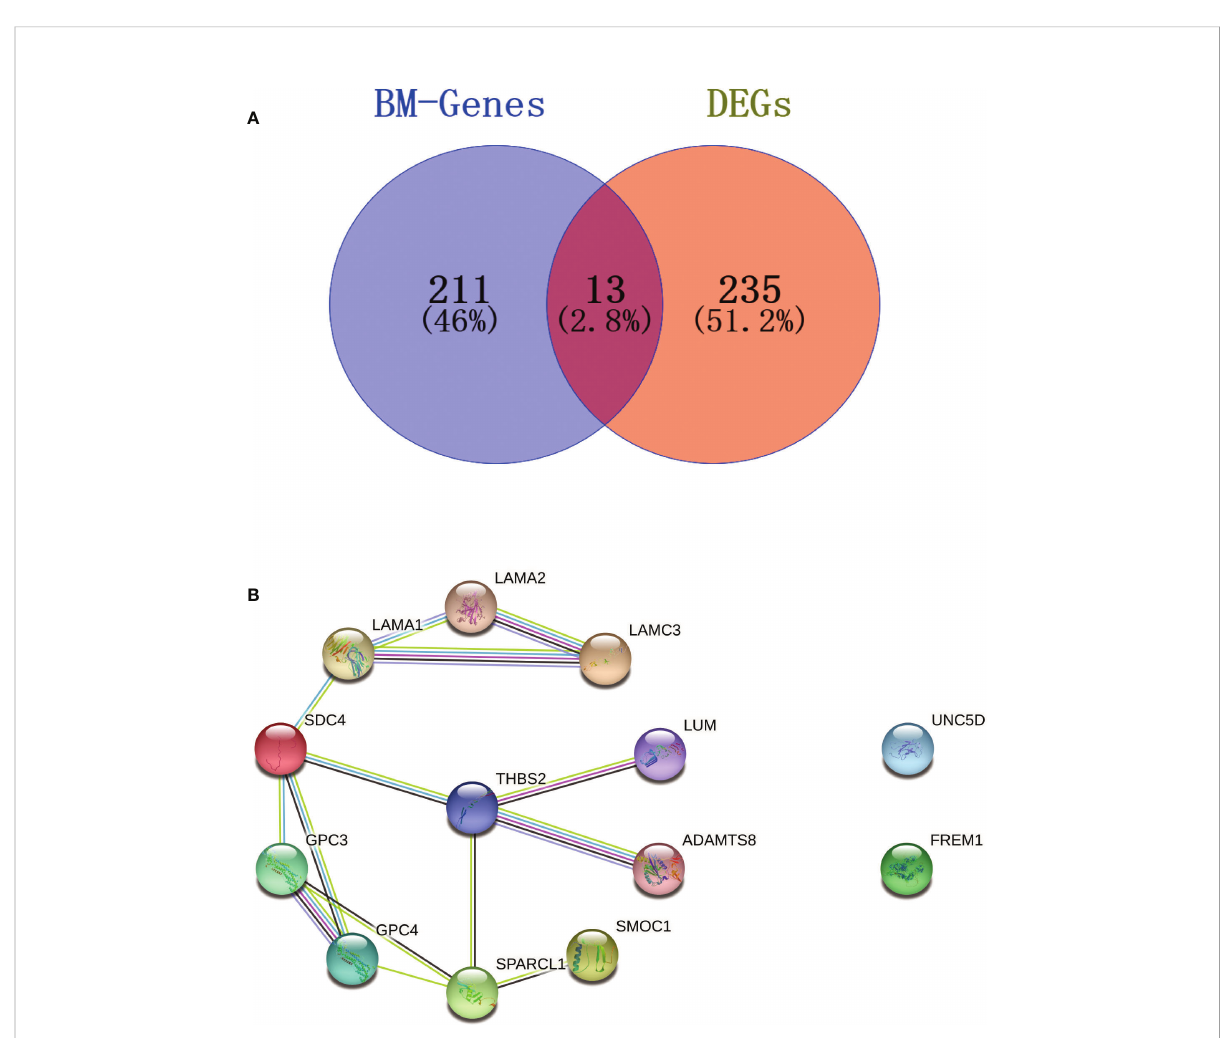
FIGURE 4 Venn diagram and PPI network. (A) Venn diagram of BM genes and DEGs; the intersection in the middle represents the identi fi cation of BM genes from DEGs. (B) PPI network; the cluster on the left shows how the 11 BM genes were connected with each other; the two genes on the right were irrelevant genes.